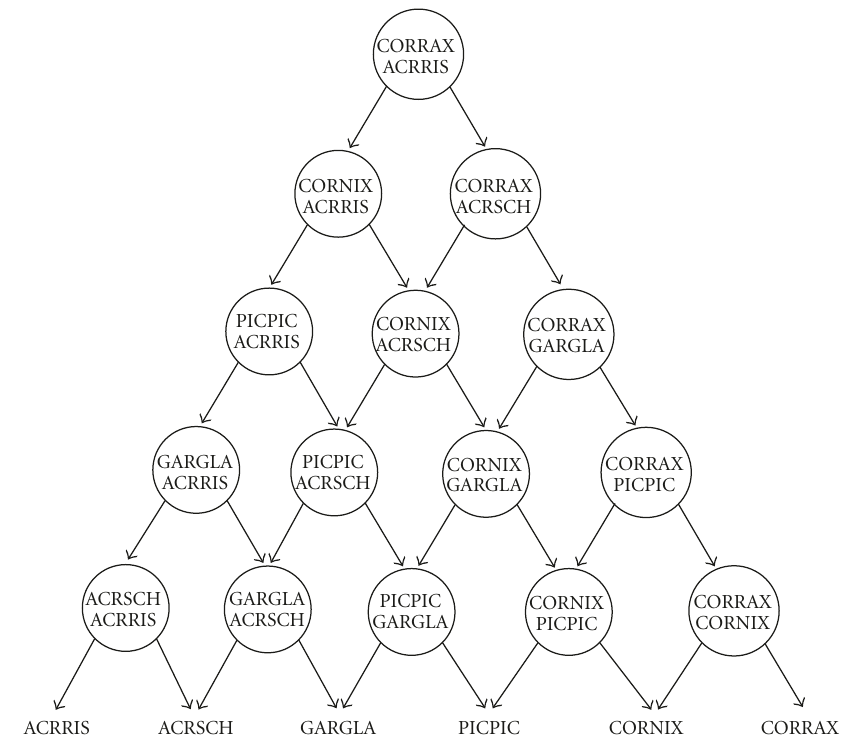
Figure 2: Topology of the decision tree classifier.